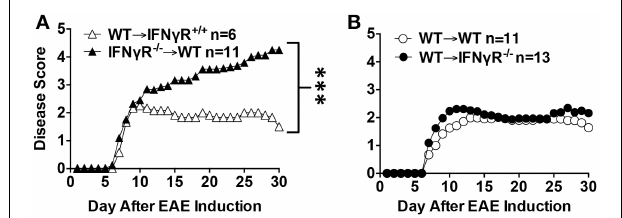
( Figure 1B ) as compared to control WT chimeras. Atypical disease was observed only rarely in our studies (data not